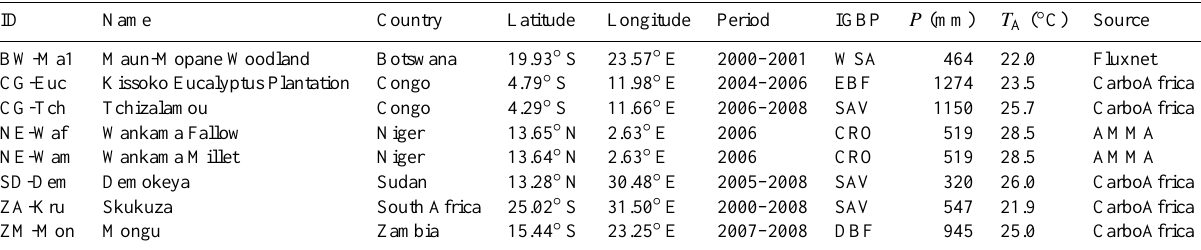
Table 4. Eight micrometeorological stations throughout sub-Saharan Africa. Ecosystems are identified with the IGBP convention: crop- lands/natural vegetation mosaic (CRO), evergreen broadleaf forest (EBF), open shrublands (OSH), savanna (SAV), and woody savanna (WSA). P and T A are the annual total precipitation and average air temperature,